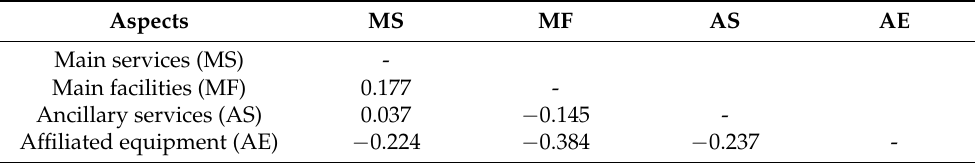
Table 8. The net influence matrix of bike-sharing service